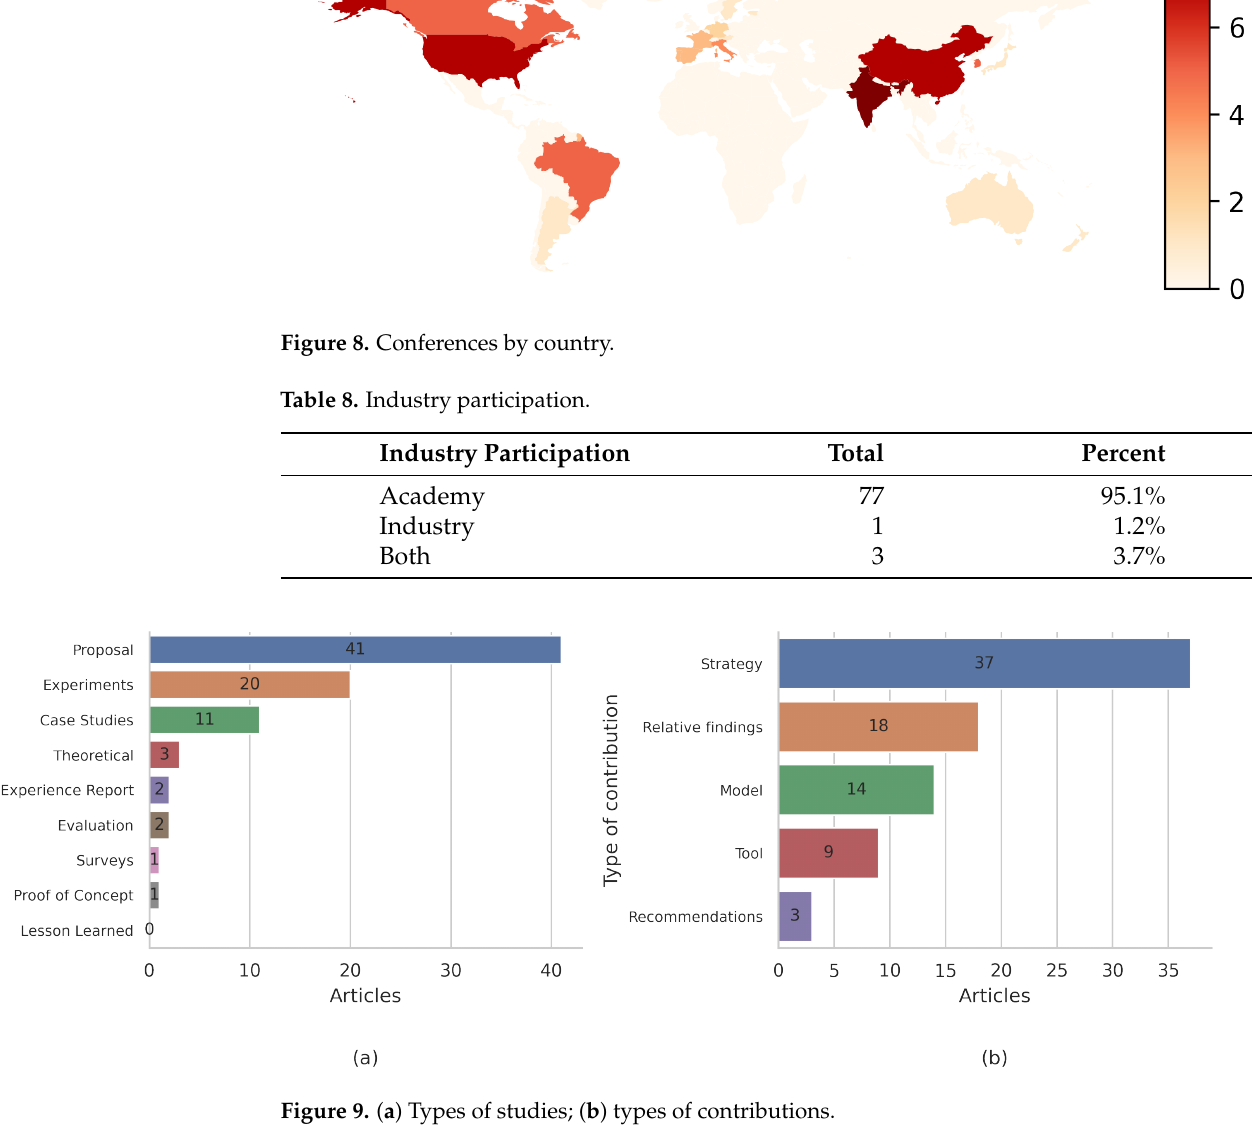
Figure 9. ( a ) Types of studies; ( b ) types of contributions. RQ-C3: What type of research method was